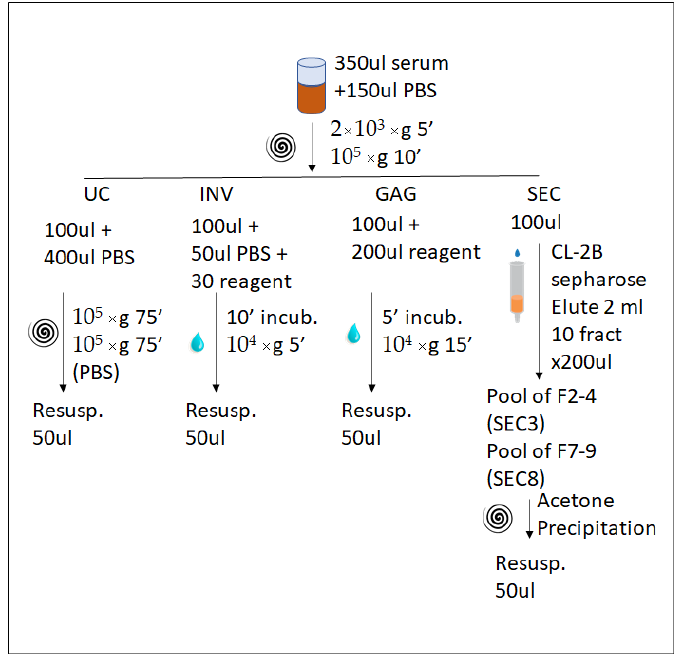
Figure 1. Schematic representation of the EV separation design. Each serum was diluted (the 100 µL loaded for each test contains 80 µL of undiluted serum), cleared and subsequently divided in four aliquots processed by four different techniques, ultracentrifugation (UC), INV (Total Exosome Purification kit, Invitrogen, Thermo Fisher Scientific, Waltham, MA, USA), GAG (Exo-GAG precipitation solution, Nasabiotech, A Coruña, Spain) and SEC (size exclusion chromatography). The results presented in this study were obtained from four independent biological replicates.